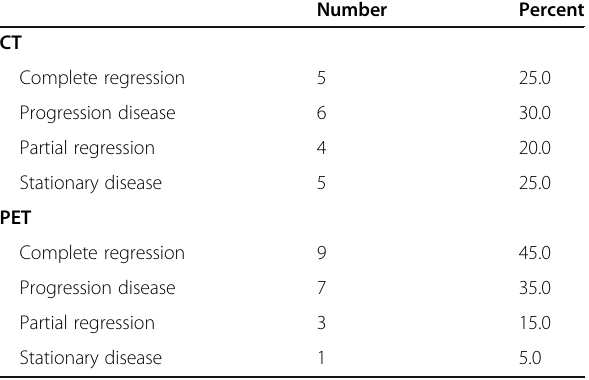
Table 8 End of treatment distribution of the study group